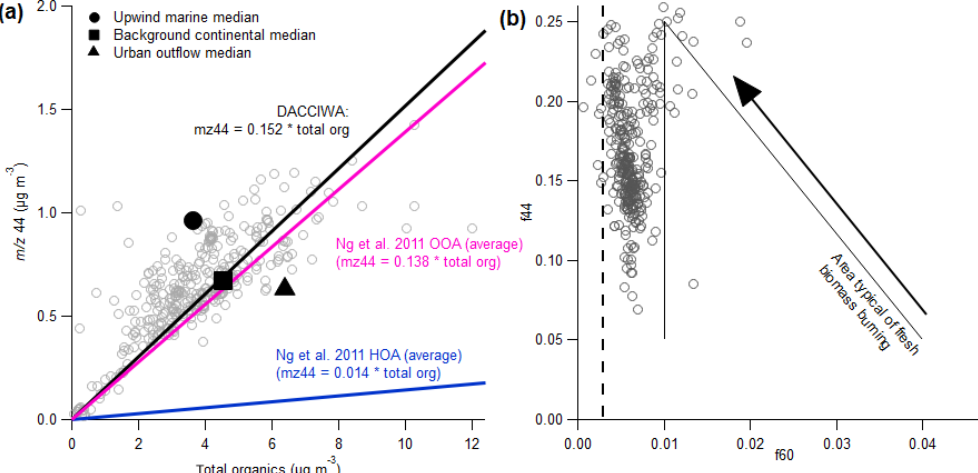
Figure 6. (a) Values of m/z 44, a strong indicator of aged organic aerosol, plotted against the total organic aerosol mass. The pink and blue lines show the average contribution of m/z 44 to the total for oxidised organic aerosol (OOA) and hydrocarbon-like organic aerosol (HOA). Grey circular markers show datapoints from the DACCIWA campaign. Median observations from each of the three regimes are shown as black shapes. (b) The fractional contribution of m/z 44 ( f 44) vs. m/z 60 ( f 60). Fresh biomass burning aerosol is generally located within the triangle shown by the two black lines (Cubison et al., 2011) , with fresher aerosol lower in the triangle. The dashed line is representative of aerosol that is not from fresh biomass burning. While m/z 60 aerosol is present here, the low contributions suggest that fresh biomass burning is not a dominant contributor towards the total organic aerosol